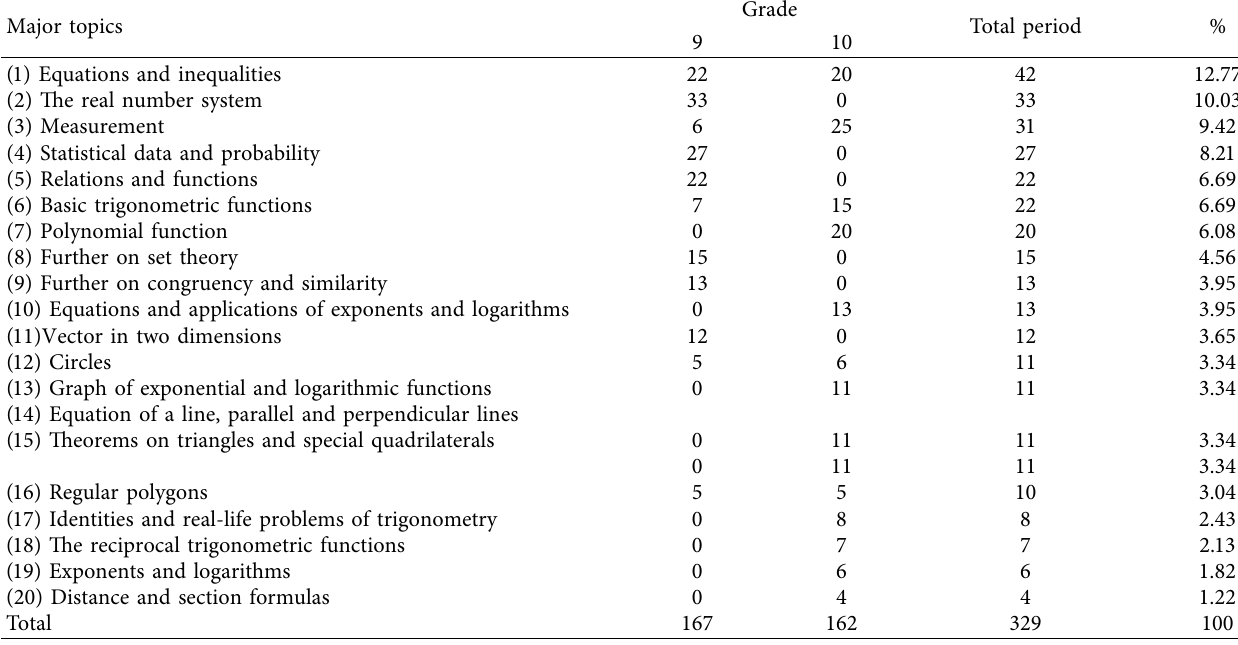
Table 5: Major topics and period allotments of grades 9 and 10.